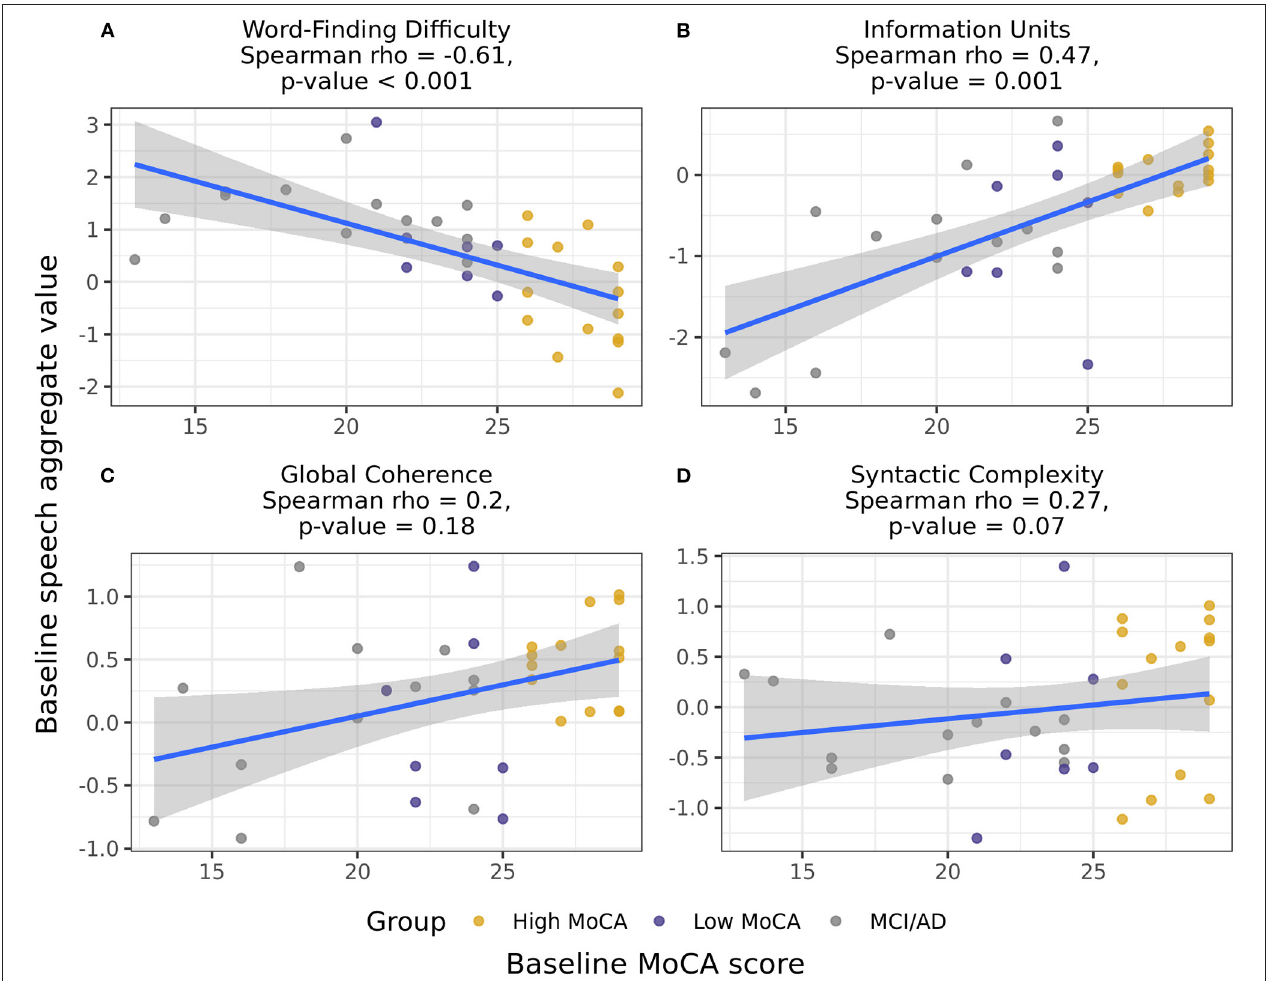
FIGURE 3 | Correlations between the baseline speech aggregates scores and baseline MoCA scores, including participants in all three groups. Word-finding difficulty (A) and Information units (B) had significant correlations with baseline MoCA scores, indicating that those with higher MoCA scores demonstrated less word-finding difficulty and increased accurate information content in their descriptions. Global coherence (C) and Syntactic complexity (D) were not significantly correlated with baseline MoCA